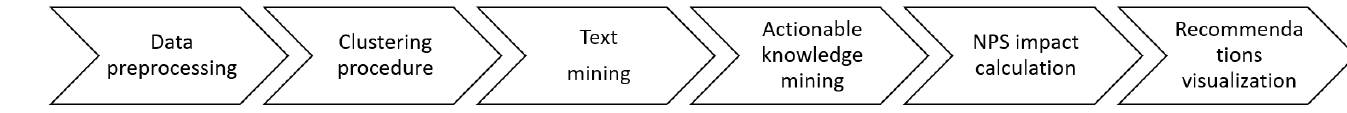
Figure 5. Sentiment analysis based procedure for generating recommendations for customer loyalty improvement. The primary step is text mining which is used to transform text data into a structured form, used for further data